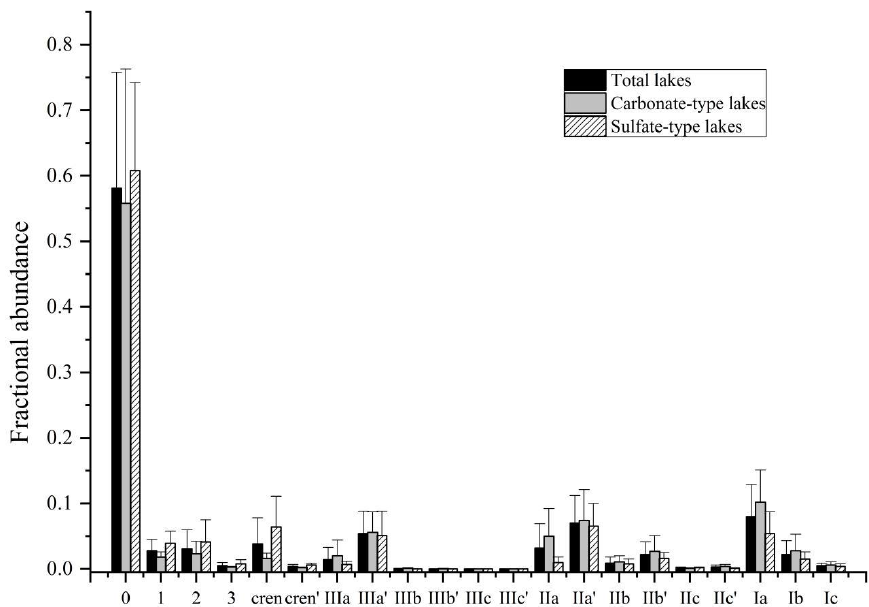
Figure 2. Concentrations of individual GDGTs in surface sediments.